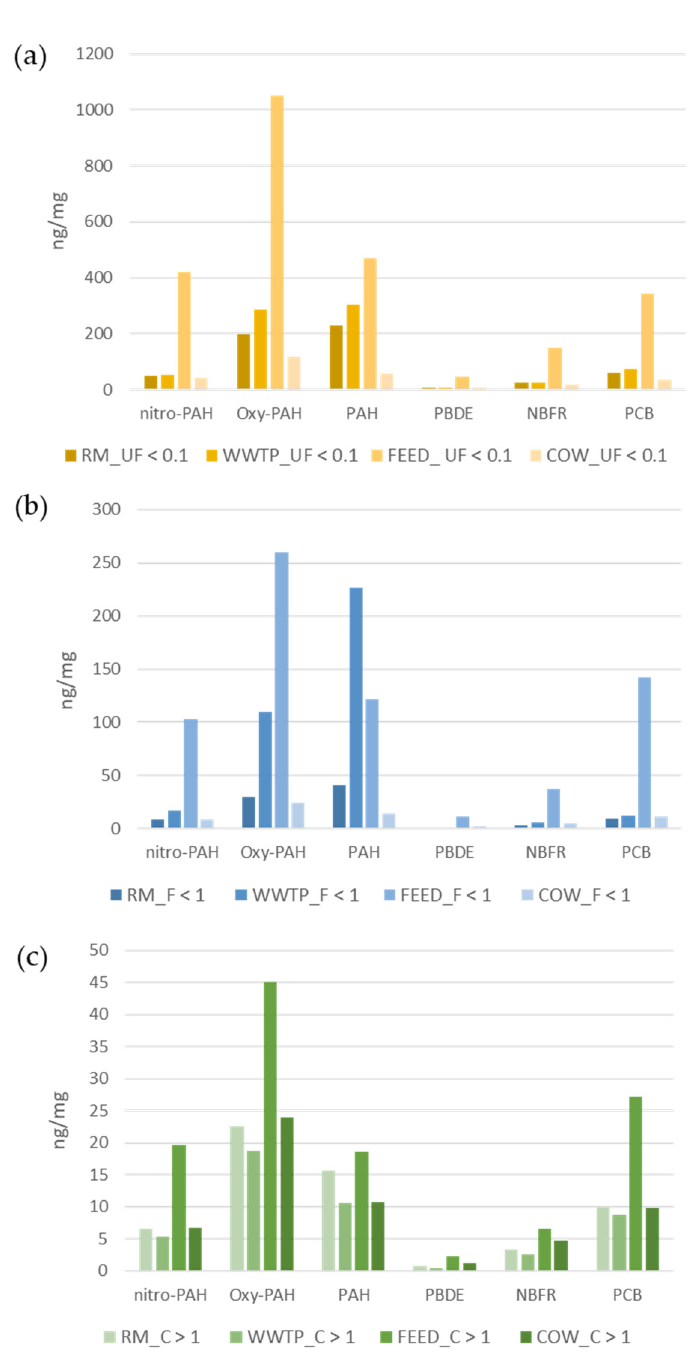
Figure 4. Distribution (ng per mg of PM) of all groups of organic substances in ultrafine ( a ), fine ( b ) and coarse ( c ) fractions of PM.